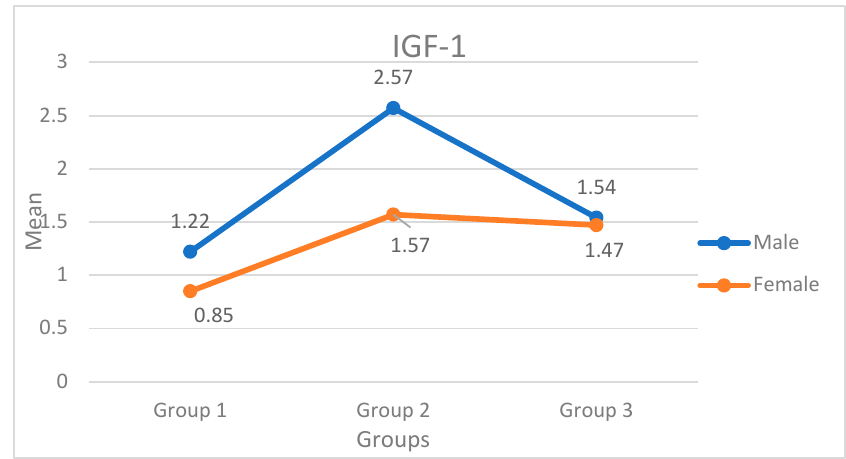
Figure 2. Graphical representation showing IGF-1 levels based on groups and gender.